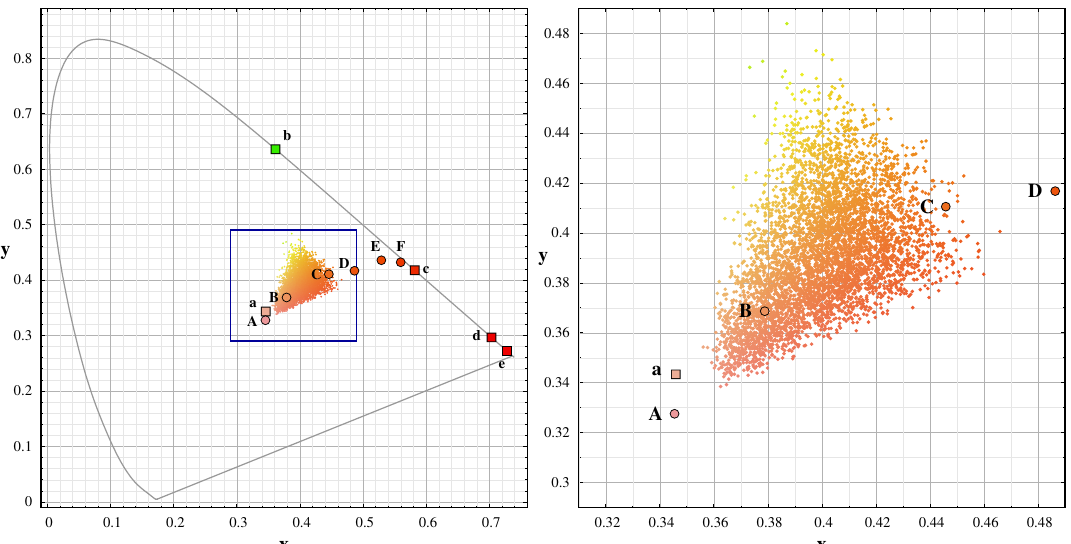
Figure 5. CIE 1931 colour diagram of the model spectra (small dots) used for the colour conversion definition. The rectangle shown in the left figure is enlarged in the right box. The large symbols represents the spectral database used for the models: A: 4900K LED; B CFL; C: 2900 KLED; D: 2400 KLED, E: HPS; F: Amber LED; a: continuous natural component, b: green oxygen emission, c: sodium emission, d: red oxygen emission, e: OH